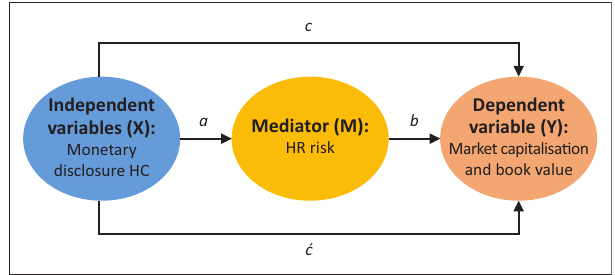
FIGURE 2: Mediation